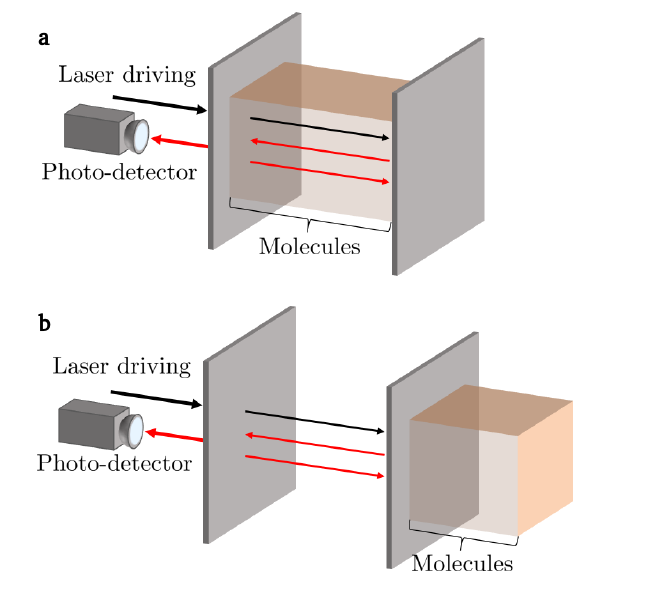
Figure 1. Current Fabry-Pérot cavity sensors can be divided into two main categories. ( a ) In the case of intrinsic sensors, the target molecules are placed on the inside, where they alter the effective cavity length via a change in refractive index. When driven by a laser field, the resonance frequency of the cavity shifts and the line width of the signal can broaden. ( b ) In the case of extrinsic sensors, the target molecules are placed on the outside of one of the cavity mirrors in order to alter its reflection rate, thereby also changing the optical properties of the